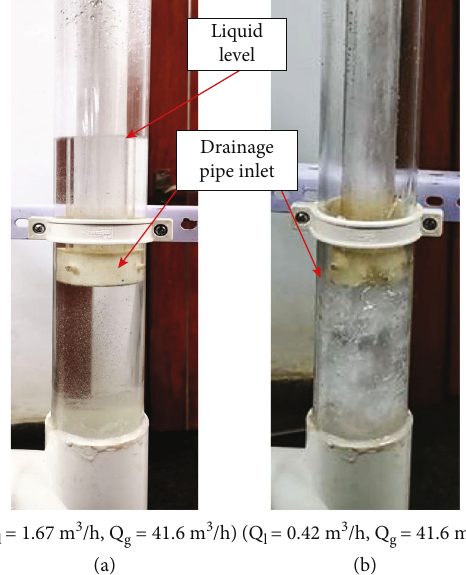
Figure 6: Liquid state of the accumulation riser with a di ff erent gas-liquid